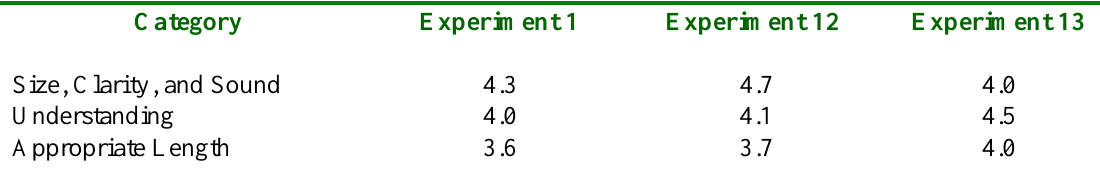
Table 1. Selected Student Ratings (1 = unacceptable to 5 = high quality ) of Online Tutorial